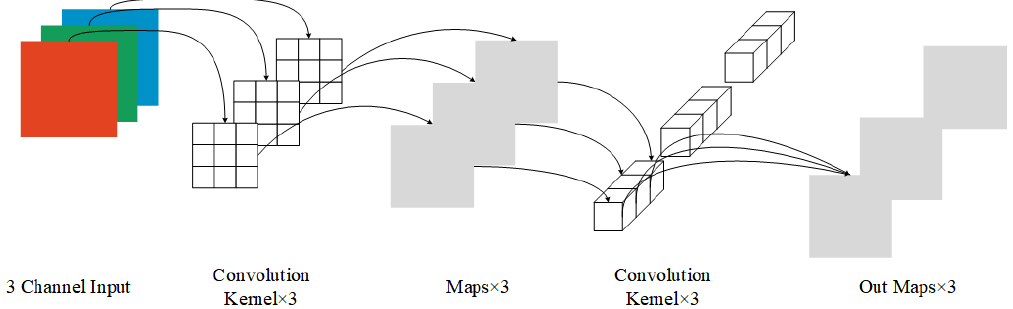
Figure 4. Schematic diagram of depthwise separable convolution.